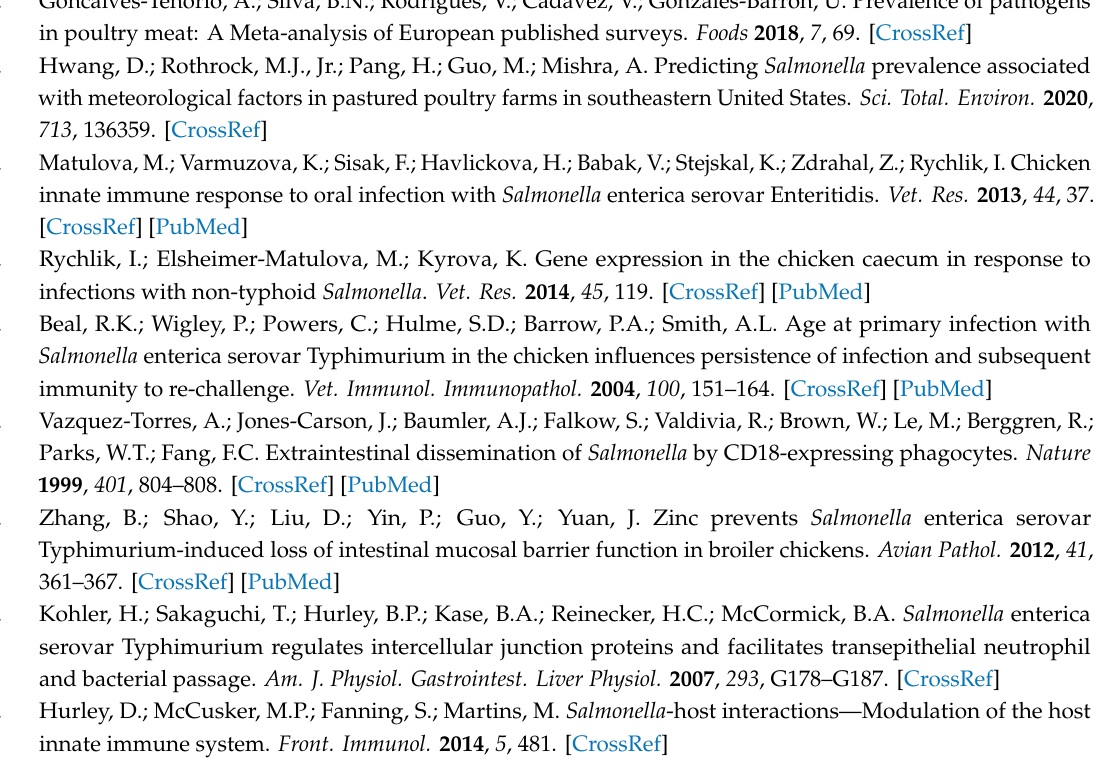
Table S1. Composition and nutrient levels in the basal diets (dry matter basis); Table S2. The primers for quantitative real-time PCR; Table S3. Sequences of the primers used for the determination of the microbial population; Table S4. E ff ects of graded Mn on MnSOD and inflammatory cytokine expressions in spleen, thymus, and bursa of broilers following oral S. Typhimurium; Figure S1: E ff ect of dietary Mn alterations on the activation of redox-sensitive signaling and downstream transcription factors in thymus and bursa of birds challenged with S.